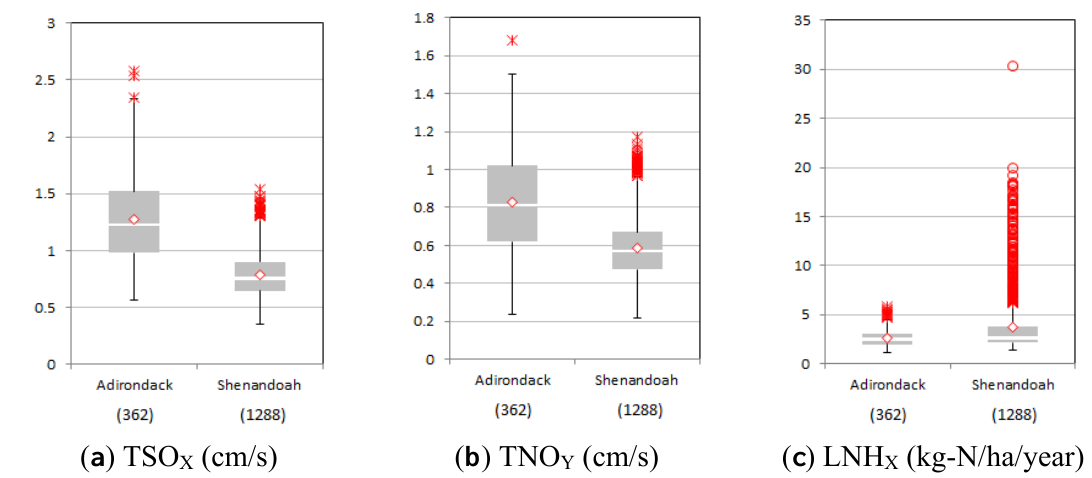
Figure 5. Box and whisker plots for variability of ( a ) TSO across all the grid cells at each case study area and all the model simulations. The number in parentheses represents the number of each sample data. The inner quartiles of each data sample are represented by a stack of two gray boxes, separated at the median by a thin line. The height of the gray boxes together makes up the interquartile range (IQR). The range of data falling within 1.5 IQRs of the median is represented by whiskers. Any outliers that fall between 1.5 and 3 IQRs from the median are represented by asterisk markers, while any outliers falling beyond 3 IQRs from the median are represented by circular markers. The average of each sample is represented by a diamond